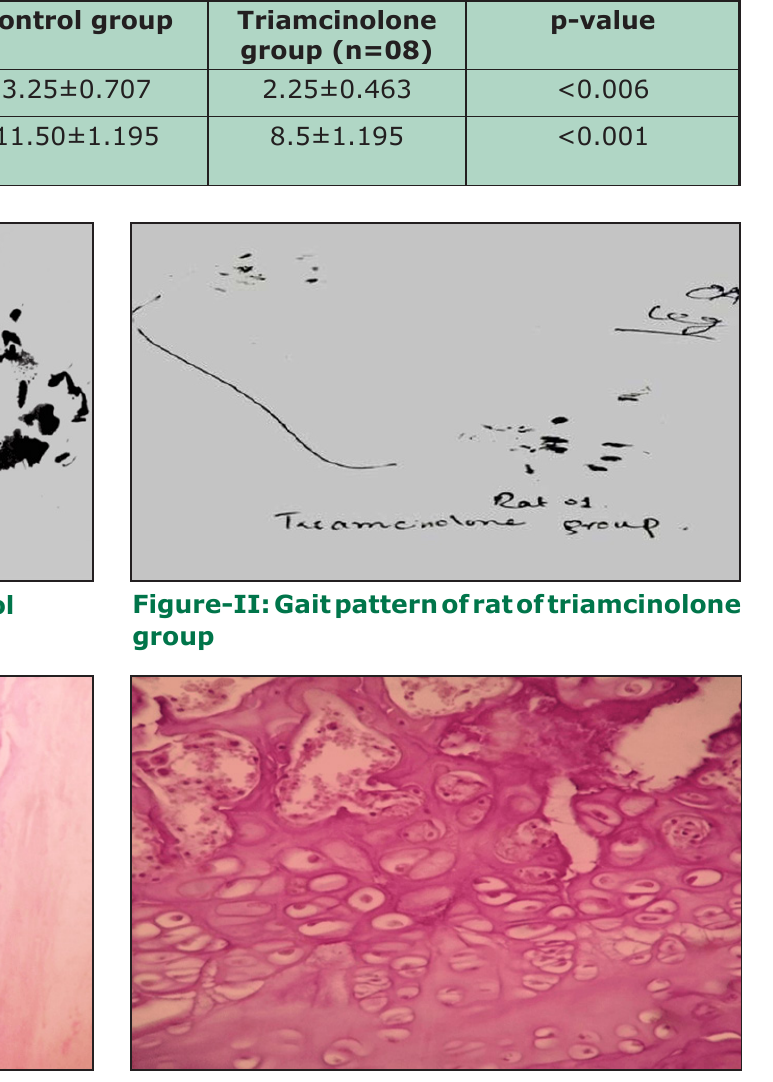
Figure-III: Photomicrograph of distal tibia of a rat of group control group.